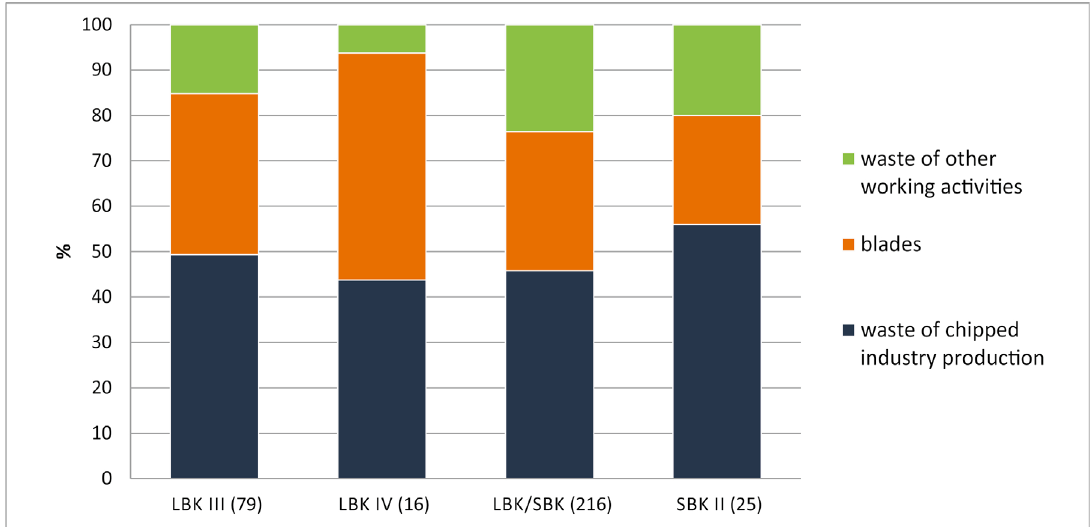
Figure 12. Categories of chipped stone industry according to the types of working activities during the chronological levels. Totals of determinations for each chronological level are represented in